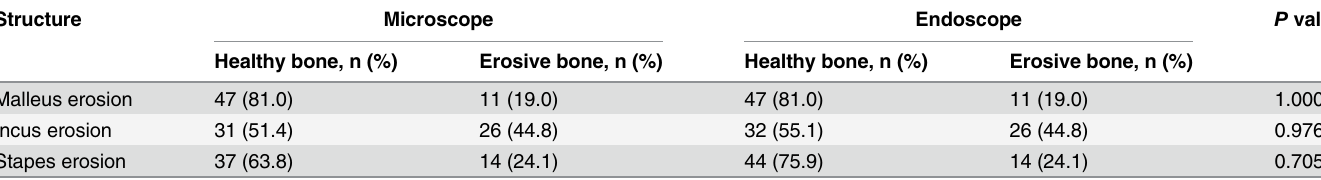
Table 3. Ossicular chain erosion in the microscopic and endoscopic views.